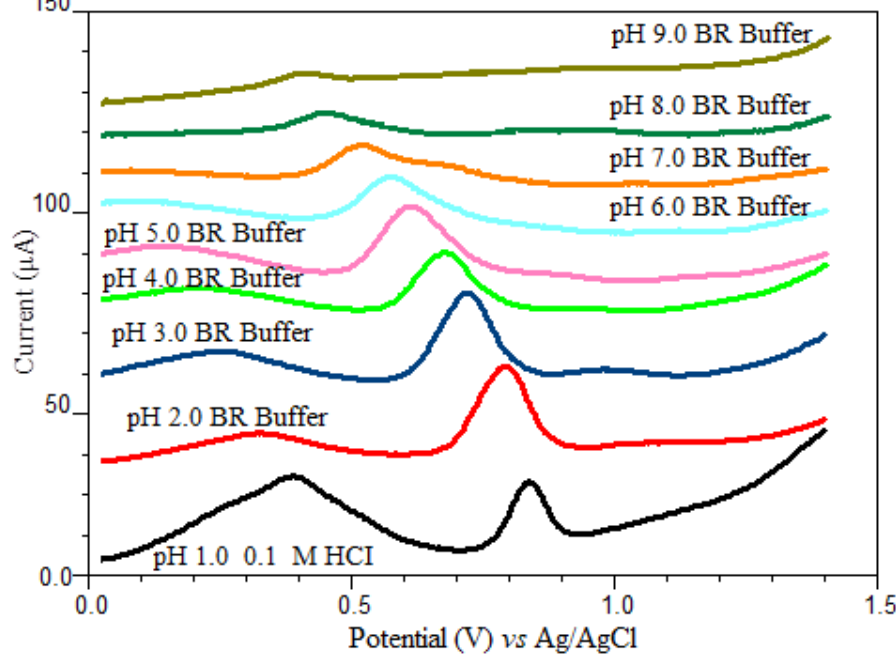
Figure 3. SWSV voltammograms of 6.0 mg/L oxyclozanide in HCl solution and Britton–Robinson buffer at different pH values ( t acc = 60 s and E acc = 0 V).